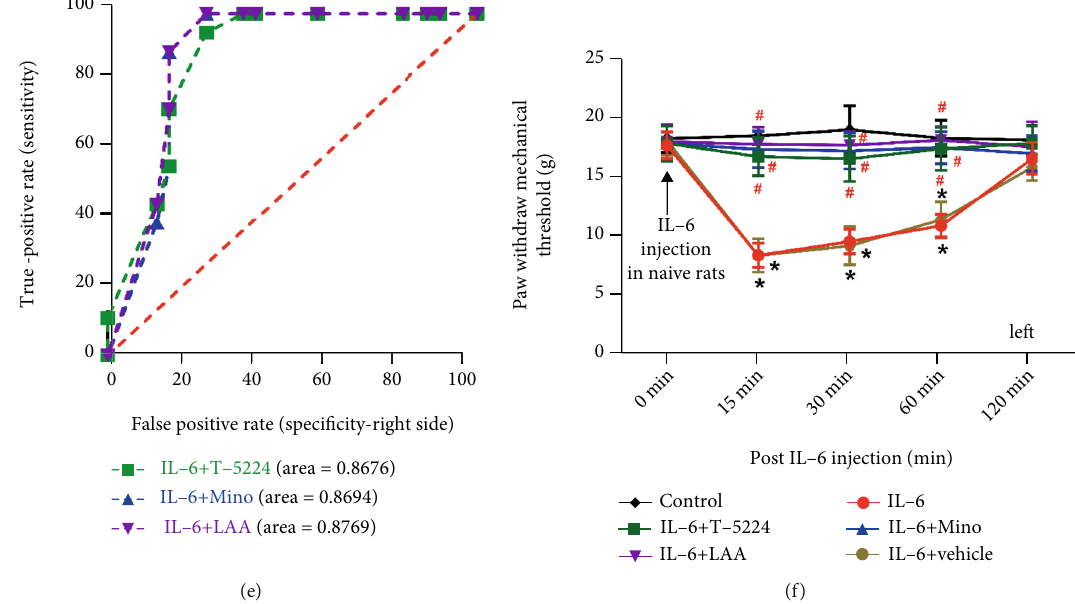
Figure 2: T-5224, Mino, and LAA ameliorated mechanical allodynia, in fl ammatory pain, and IL-6 induced hyperalgesia in rats. (a) Line plots indicate the e ff ects of T-5224 (c-Fos/AP-1 inhibitor, 500 μ g/50 μ L), minocycline (Mino, 100 μ g/50 μ L), and L-2-aminoadipic acid (LAA, 1mg/50 μ L) on ipsilateral paw withdrawal mechanical thresholds (PWMTs) in FCA-induced in fl ammatory pain. ∗ P < 0 : 05 versus control. # P < 0 : 05 versus FCA; one-way ANOVA with Bonferroni tests. (b) ROC curves and AUC of T-5224, Mino, and LAA on the ipsilateral side of FCA-treated rats. (c) Intrathecal injection of T-5224, Mino, and LAA did not alter FCA-induced mechanical nociception on the contralateral nonin fl amed side ( P > 0 : 05 ). (d, f) Interleukin-6 (20 ng/50 μ L) microinjection reversed T-5224-induced mechanical hyperalgesia (500 μ g/50 μ L), Mino (100 μ g/50 μ L), and LAA (1 mg/50 μ L) in the right and left hind paws of naïve rats; ∗ P < 0 : 05 versus control. # P < 0 : 05 versus IL-6, one-way ANOVA with Bonferroni tests. (e) ROC curves and AUC for T-5224, Mino, and LAA in the right hind paws of naïve rats. Data are shown as means ± SD ( n = 6 ). AUC: area under receiver operator characteristic curves; ROC: receiver operator characteristic